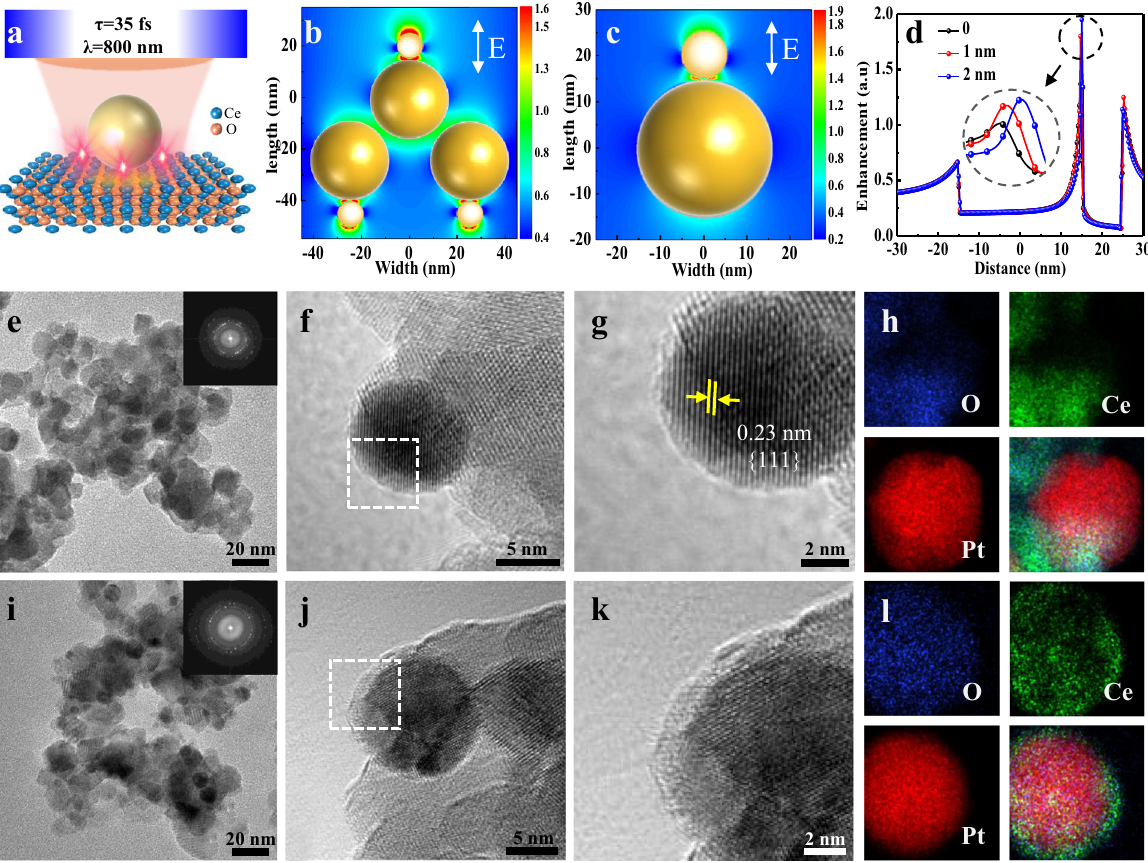
Fig. 2 Ultrafast laser induced SMSI. a Schematic of the setup for ultrafast laser irradiation of Pt/CeO 2 . b , c Calculated electric fi eld distribution and ( d ) the enhancement pro fi les along the longitudinal axis of the Pt/CeO 2 excited at an 800-nm wavelength with parallel polarization. Inset is the enlarged image of the enhanced electric fi eld at the interface between Pt and CeO 2 (width = 0, 1, 2 nm). e , f TEM image of as-prepared Pt/CeO 2 . Inset is the FFT. g The enlarged image of the areas marked in ( f . h ) EDS elemental mapping of as-prepared Pt/CeO 2 . i , j TEM image of laser-irradiated Pt/CeO 2 . Inset is the FFT. k The enlarged image of the areas marked in ( j ). l EDS elemental mapping of laser-irradiated Pt/CeO 2